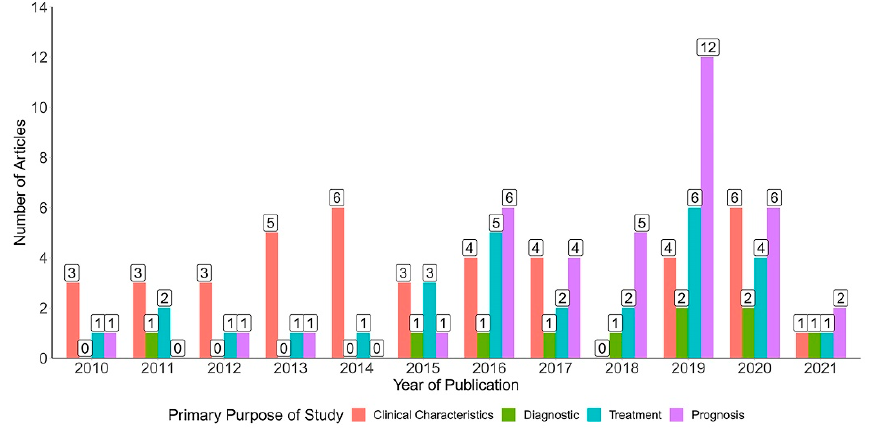
Figure 3. Year of publication and number of articles.